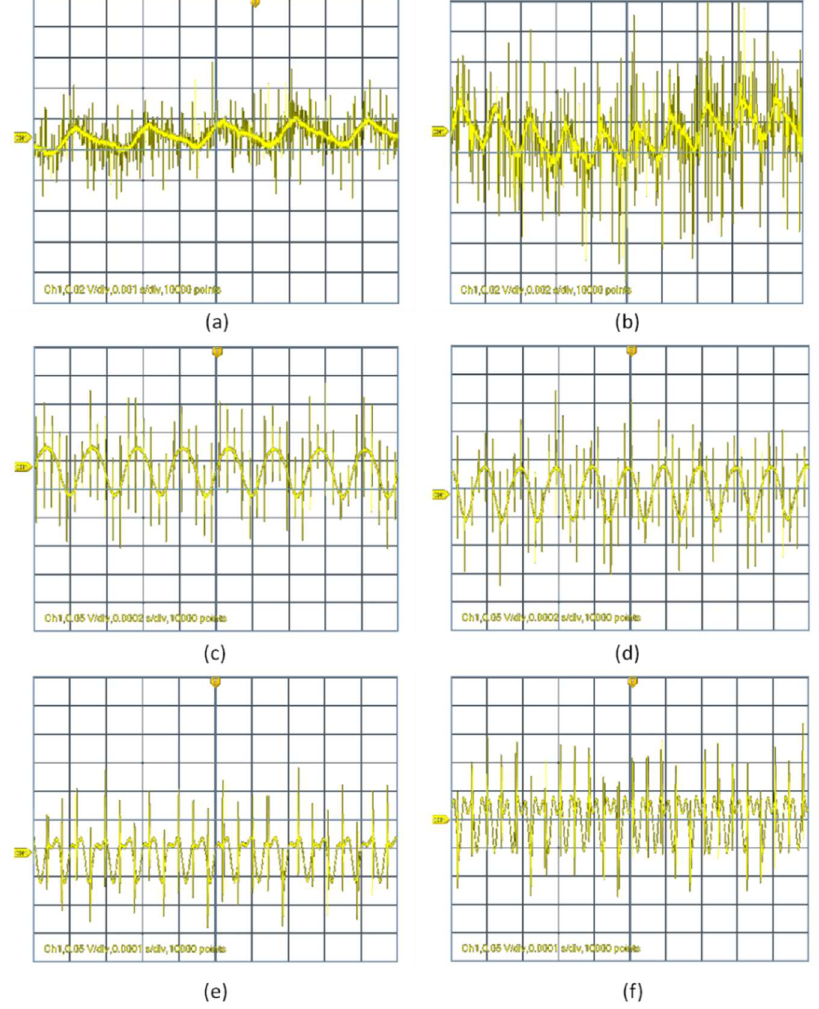
Figure 7. Examples of retraced acoustic wave signals at different input frequencies at an applied voltage of 1.2 volts. The used frequencies are ( a ) 300 Hz, ( b ) 500 Hz, ( c ) 4 kHz, ( d ) 5 kHz, ( e ) 15 kHz and ( f ) 20 kHz. All wave signals graphs have a y-axis of voltage (in volts) and an x-axis of time (in seconds).